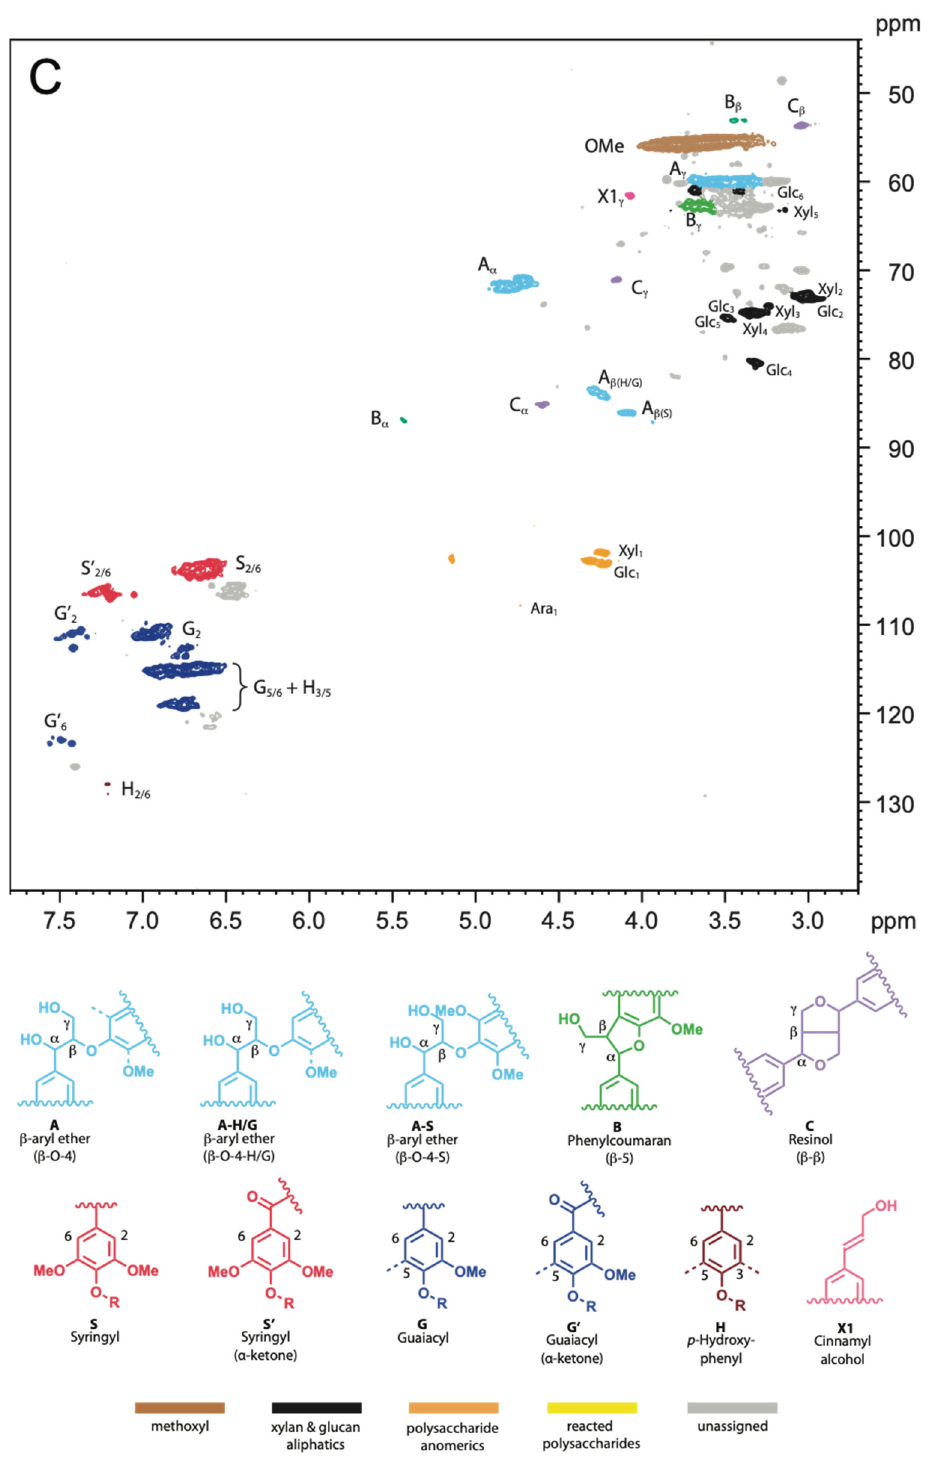
Figure 3. The partial 2D NMR spectrum of the control degraded archaeological elm ( C ) ( top ) and the chemical structures ( bottom ) of the main wood polymers present in the spectrum and the following figures.